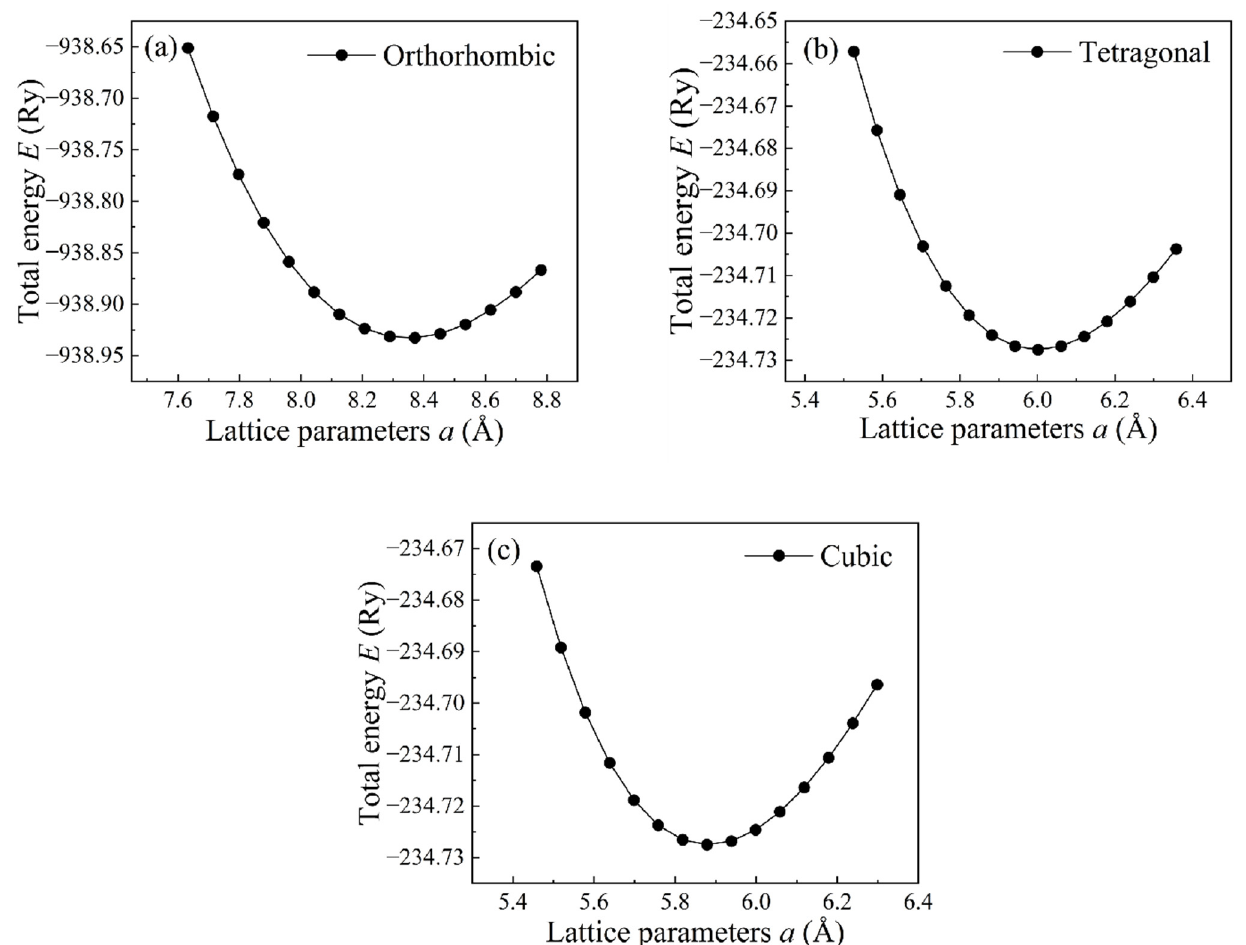
Figure 3. Variation of total energy as a function of lattice parameters for CsPbBr 3 . ( a ) orthorhombic structure; ( b ) tetragonal structure; ( c ) cubic structure.